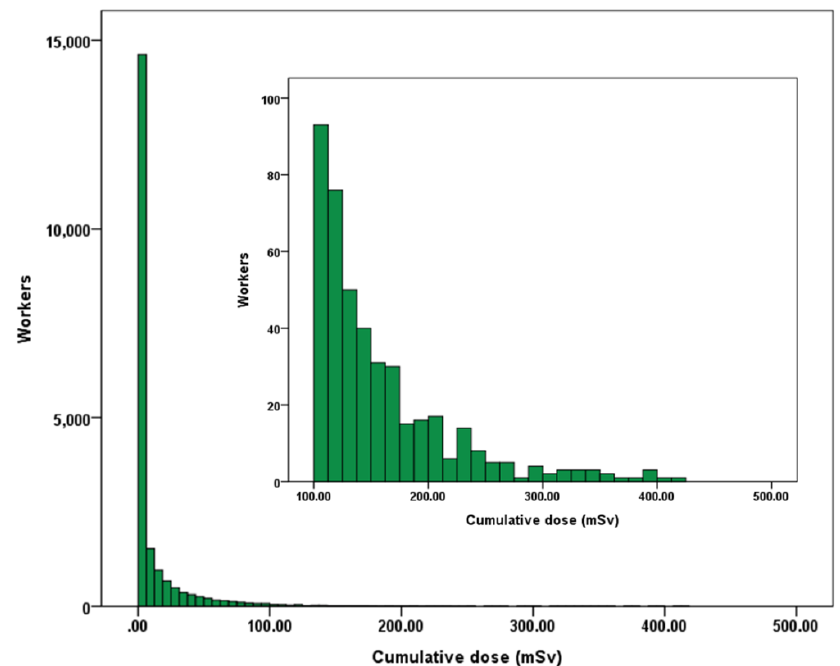
Figure 3. Distribution of cumulative dose in the cohort (1984–the 1st quarter of 2017).